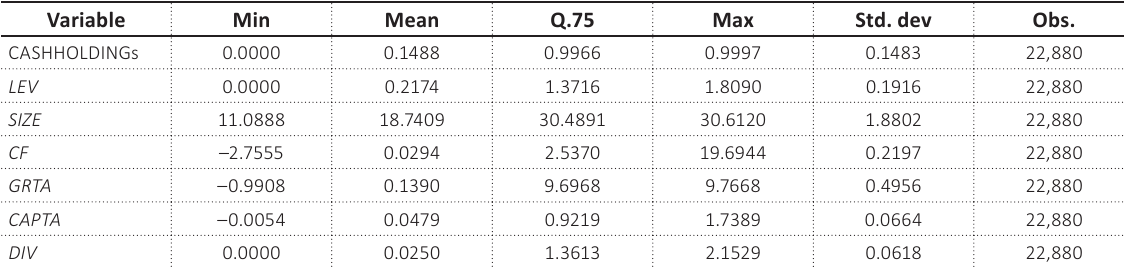
Table 1. Descriptive firm variables in the whole sample